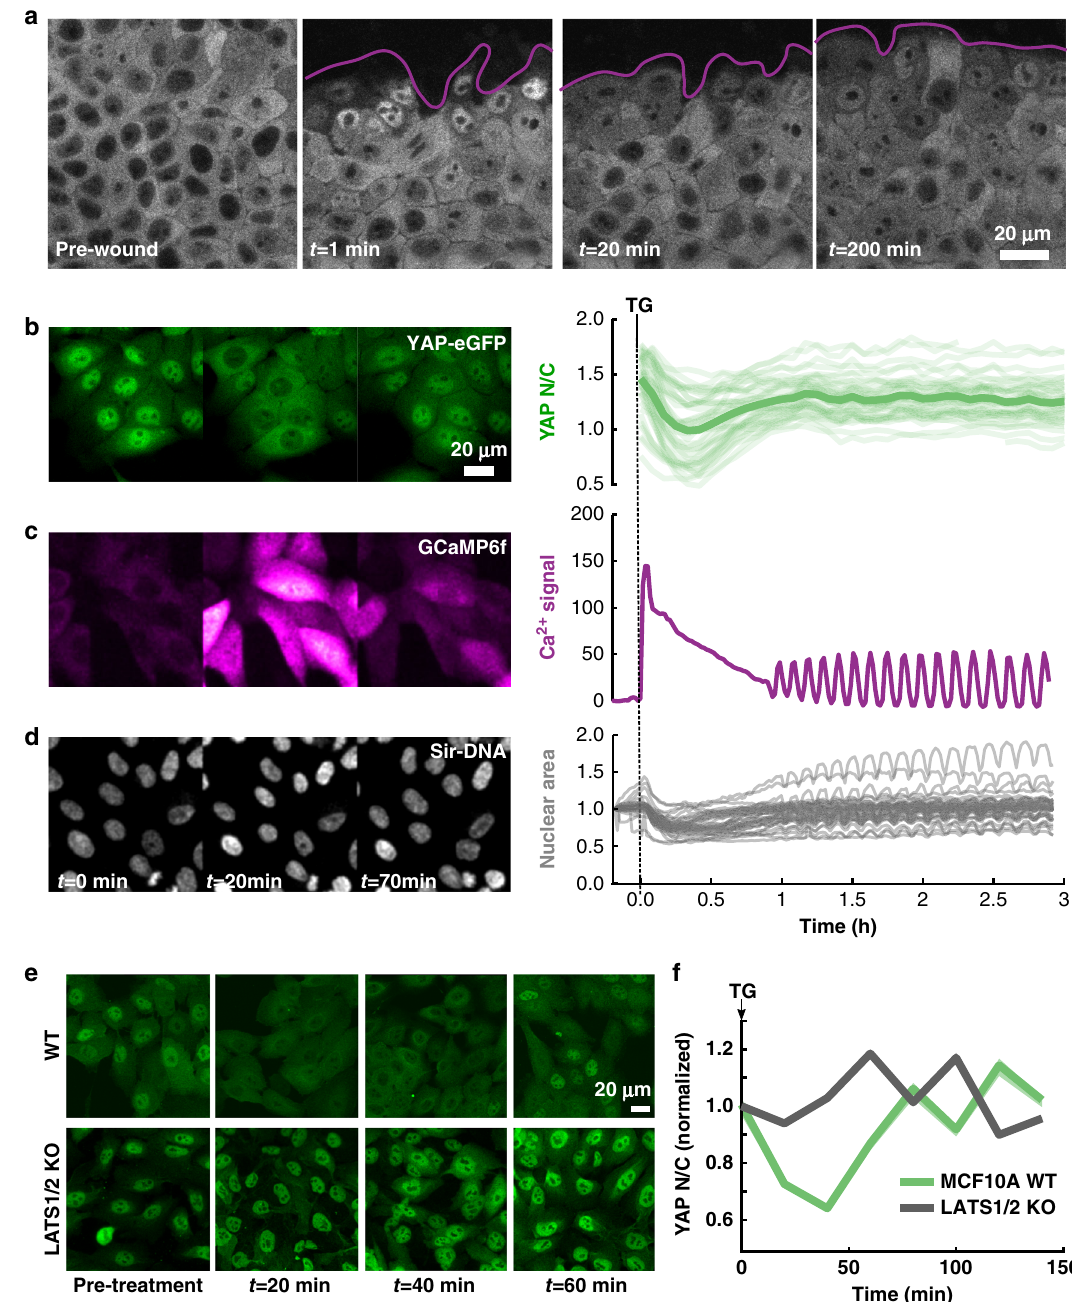
Fig. 4 YAP translocation dynamics during wound response and calcium stimulation. a Fluorescent images of YAP-eGFP before and after mechanical wounding. Wound edge highlighted in magenta. Data from one representative experiment. Repeated three times with similar results. b YAP localization, c cytoplasmic calcium signal, and d nuclear shape at different time points after induction of SOCE using 1 µ M Thapsigargin. The time stamp for b and c are the same as d . YAP N / C traces are from 43 cells compiled from two independent experiments with similar results. Nuclear area traces and GCaMP6f Ca 2 + traces are from 42 cells and two independent experiments with similar results. Mean value is shown with bold line; individual traces are displayed as transparent. Both calcium and nuclear area are normalized to the pretreatment signal value on a per-cell basis. e Immuno fl uorescence of native YAP in MCF10A wildtype cells and LATS1/2 double knockout cells after TG treatment for the indicated times. f Quanti fi cation of YAP N / C for the data in e . N / C ratio normalized to pre-treatment value, mean plotted in bold with shaded area as SEM. WT: N pre-treament = 214, N 20 min = 199, N 40 min = 144, N 60 min = 233, N 80 min = 155, N 100 min = 298, N 120 min = 181, N 140 min = 468. LATS1/2 KO : N pre-treatment = 202, N 20 min = 344, N 40 min = 329, N 60 min = 255, N 80 min = 220, N 100 min = 116, N 120 min = 607, N 140min = 435 cells. Data compiled from two independent